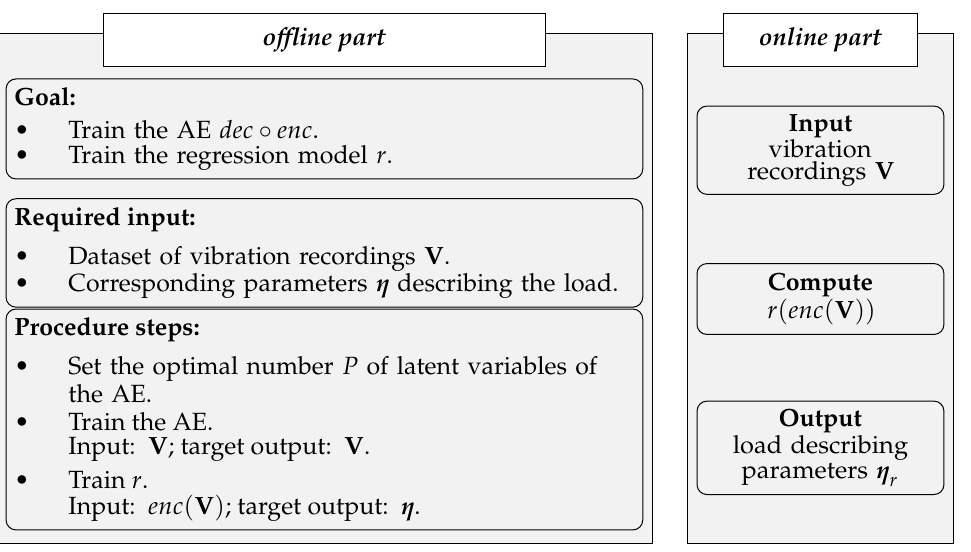
Figure 6. Proposed load identification